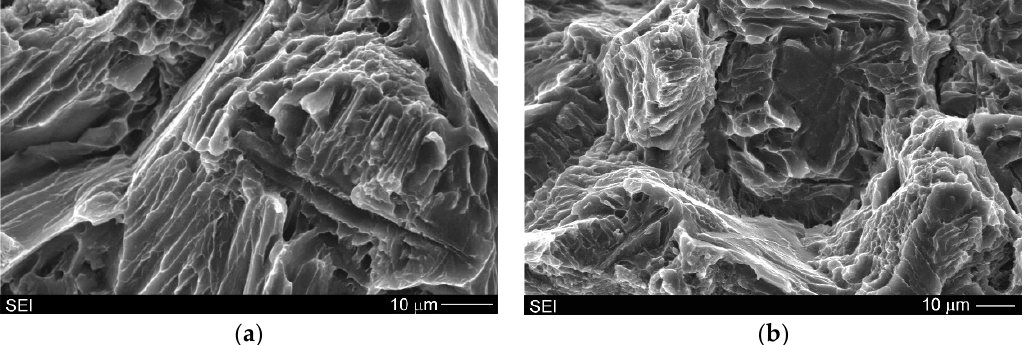
Figure 10. SEM micrographs of Mg/Mg 2 Si–HO composite fracture surfaces illustrating cracking through Mg + Mg 2 Si eutectic (after uniaxial tensile test) (( a , b ) taken from different areas of fracture surfaces of the same material).